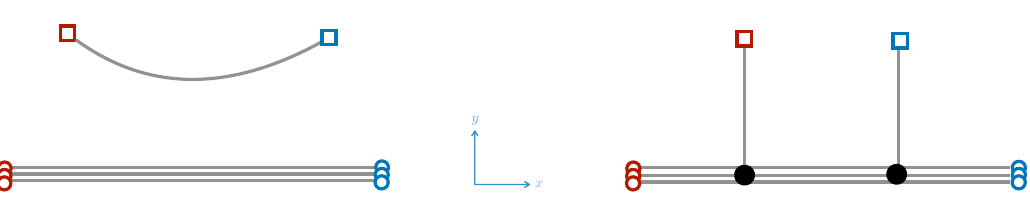
Figure 14 . The reconnected and connected brane webs for α = π . In this case everything happens on the ( x, y ) plane only. Blue squares and circles refer to 7-branes orthogonal to the ( x, y ) plane which look however as anti-branes compared to unrotated